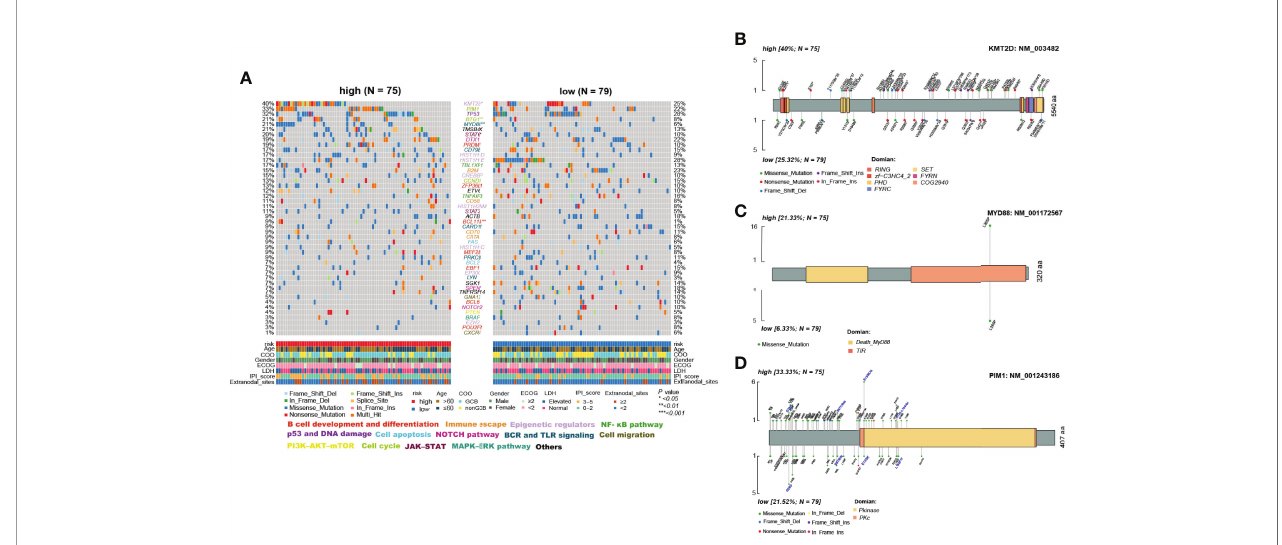
FIGURE 7 | Differences in somatic mutations between the high- and low-risk ELncSig groups in the TMUCIH validation cohort. (A) Oncoplot analysis of critical mutated genes and pathways in DLBCL between the high- and low-risk ELncSig groups (two-sided Fisher ’ s exact test). (B – D) Speci fi c mutated site analysis of KMT2D, MYD88, and